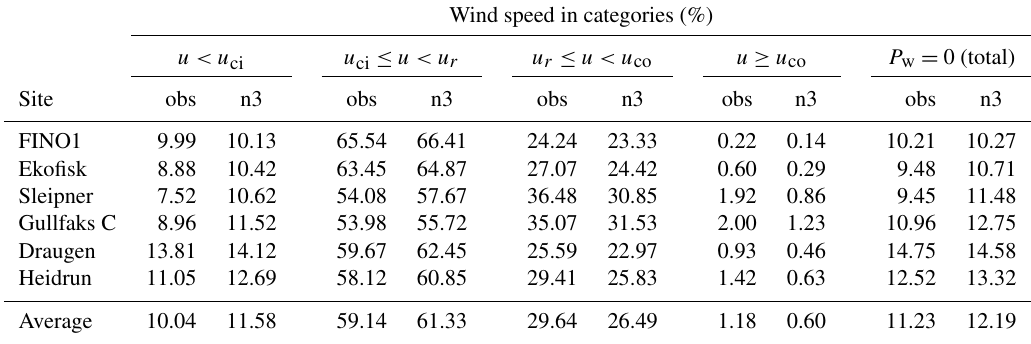
Table 10. The percentages of observed wind speeds (obs) and modeled wind speeds (n3) that fall into the following four categories: (1) the wind speed is less than the cut-in limit ( u < u ci ), (2) the wind speed interval in which the wind power is a function of the cube of the wind the total hours of zero wind power production ( P w = 0) divided by the total number of observations are shown as a